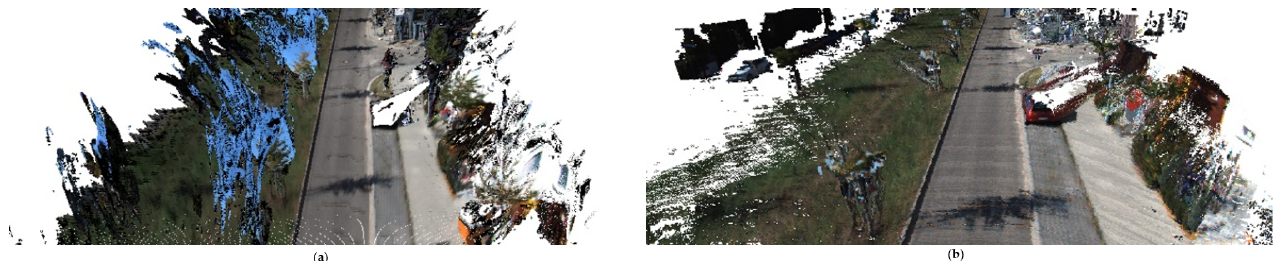
Figure 9. Comparison of 3D reconstruction quality of DynSLAM and our method for sequences 06: ( a ) reconstruction of DynSLAM, ( b ) reconstruction of our